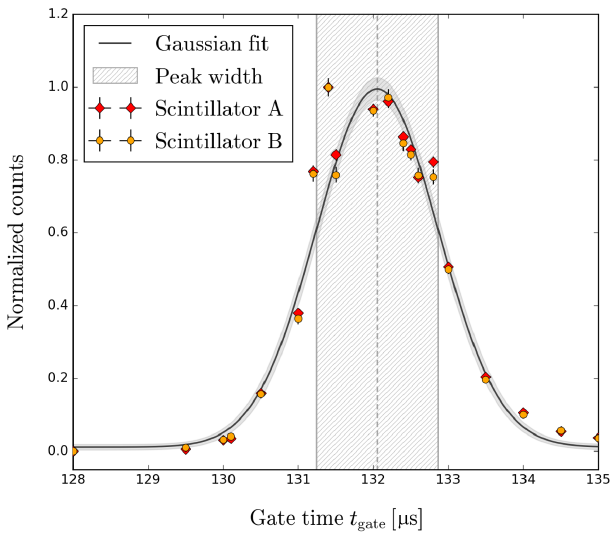
FIG. 15. Number of annihilations during a 5-s-long window after ¯ p bunches are caught inside the ALPHA-g Penning trap, for a range of gate times between 128 and 135 μ s. The number of annihilations has been normalised against shot-to-shot variation in the initial number of ¯ p. The error bars reflect Poisson counting